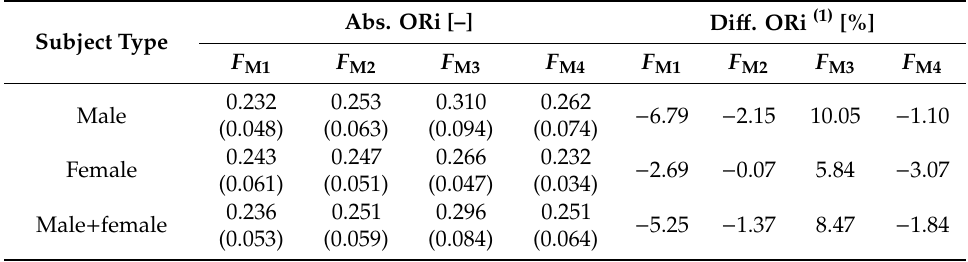
Figure 10. Comparison of differential values in [%] measured by the BPM device and determined from the PPG signal for a male (upper graphs) and female (bottom graphs) tested person lying inside the magnetic resonance imaging (MRI) device during execution of the MR scan sequence: ( a , d ) BP values in four measuring phases; ( b , e ) HR values determined from PPG and measured by BPM, related to the F M1 as a baseline; ( c , f ) mean ORi values (after LT removal). Table 3. Comparison of mean absolute ORi (std in parentheses) values of and mean differential ORi values for persons examined in the magnetic resonance imaging (MRI) device.